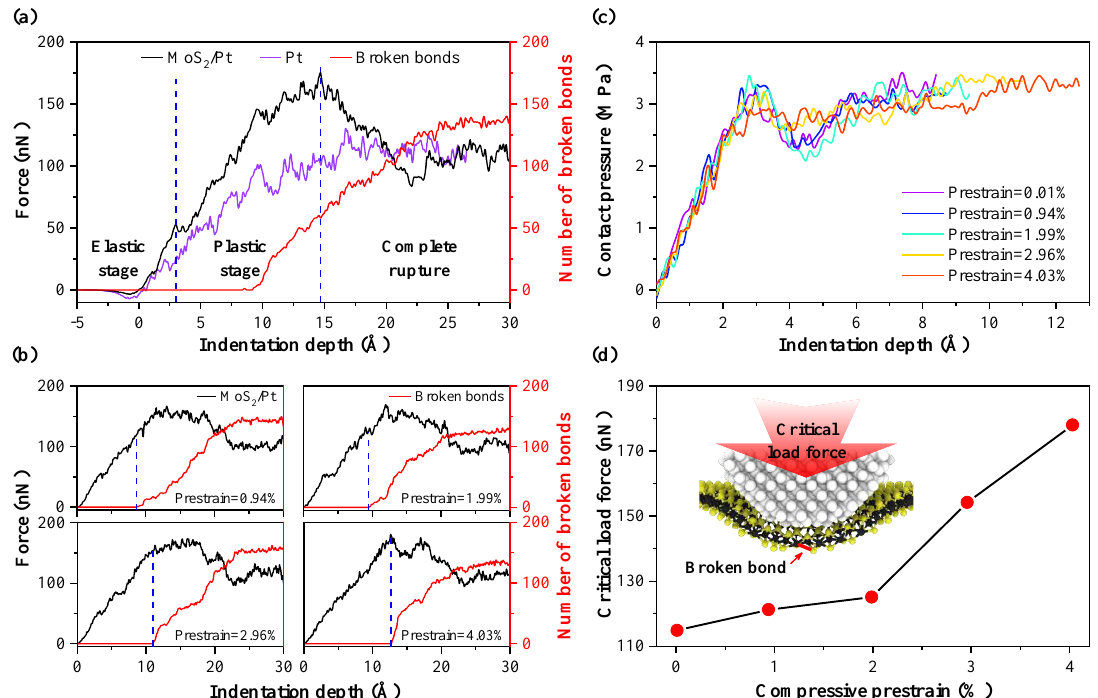
result above is consistent with previous study [48], indicates that monolayer MoS 2 improves the load bearing capacity of the Pt substrate.